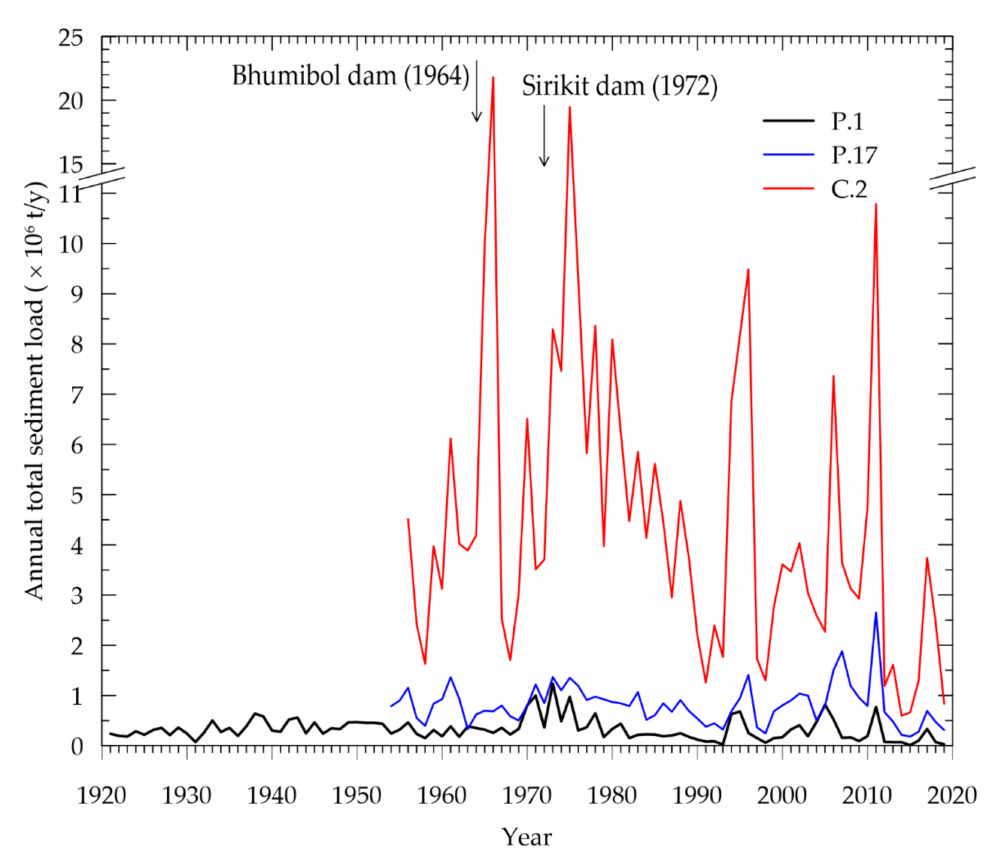
Figure 8. Time series of total sediment at Stations P.1, P.17 and